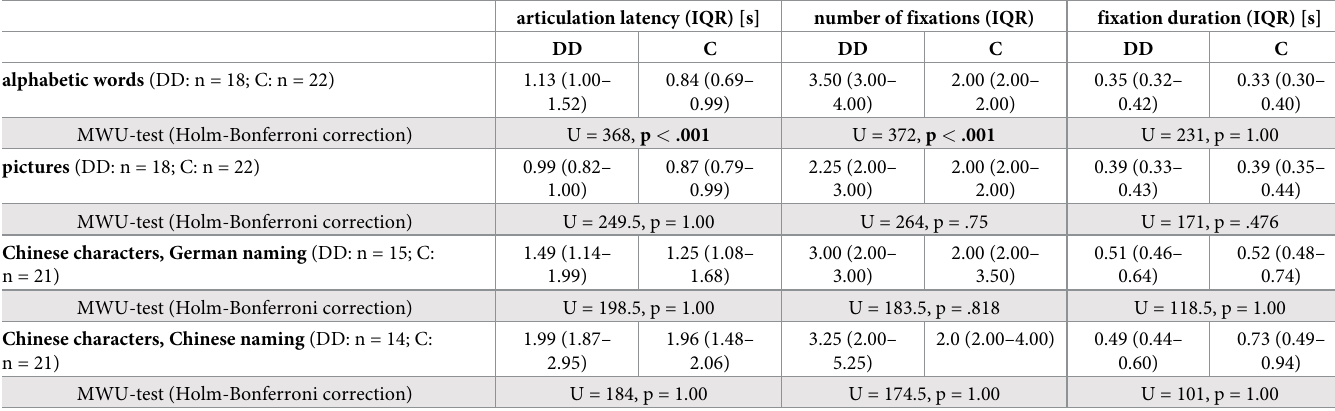
Table 2. Statistical data. Eye tracking.